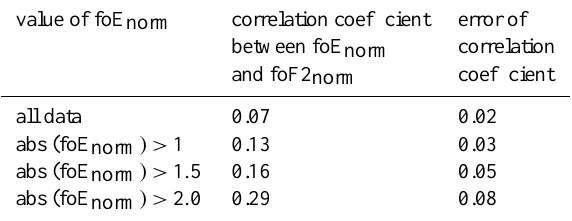
Fig. 5. Histogram showing the dependence of foE norm on the dis- tance from the epicenter. Distances are given in kilometers. The er- ror bars describing ± std are also drawn in. The values of foE norm are found by averaging over all earthquakes with a distance which is within the interval shown in the inset.